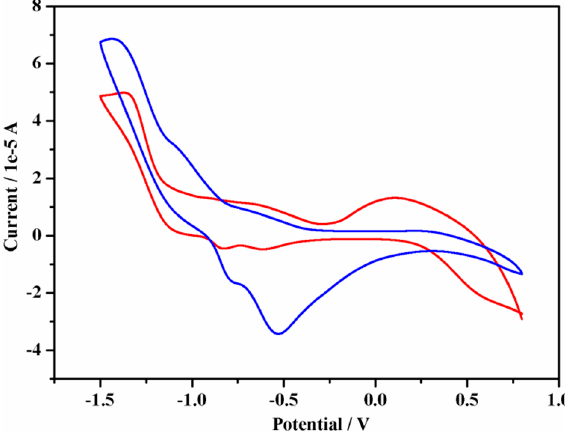
Figure 3. CV profiles of Poly( 1) – b –Poly( DDDPM ) (red line) and Poly( 2) – b –Poly( DDDPM ) (blue line).